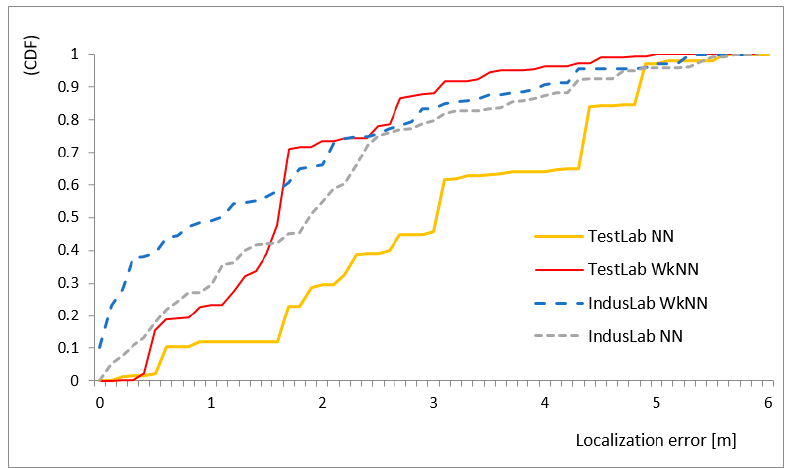
Figure 10. Comparison of localization accuracy for points with unknown RSSI values.